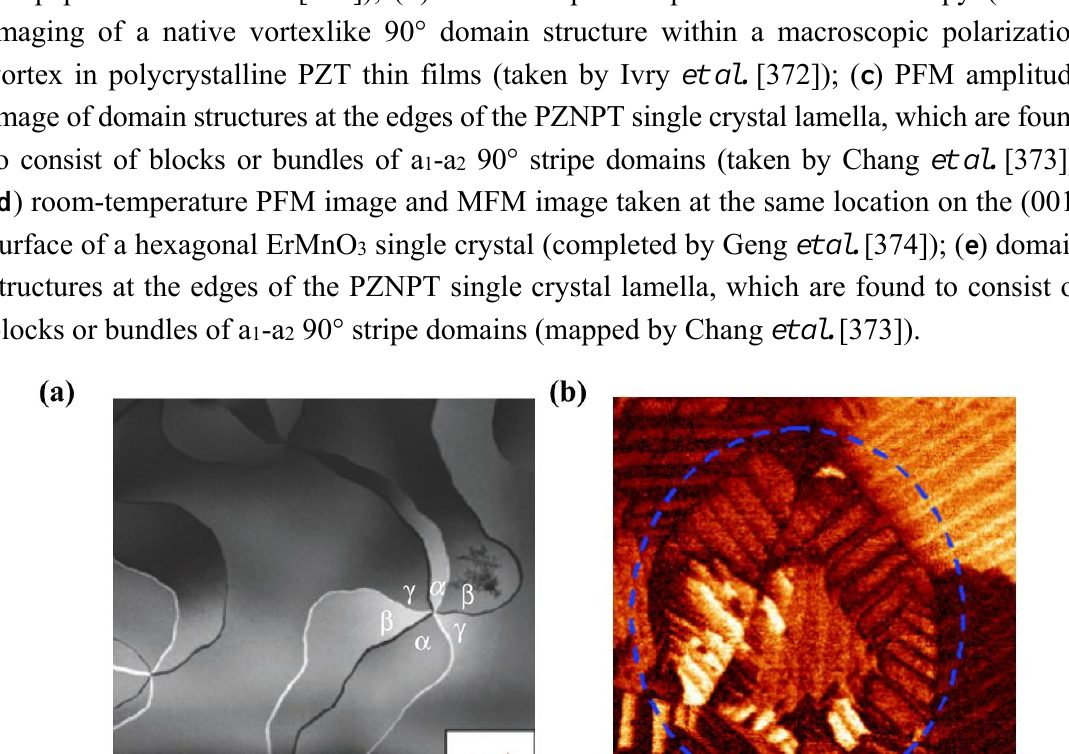
Figure 12. ( a ) TEM dark-field image of cloverleaf domain patterns in ferroelectric YMnO 3 , showing six antiphase domains ( α−β−γ−α−β−γ ) emerging from one central point (cited